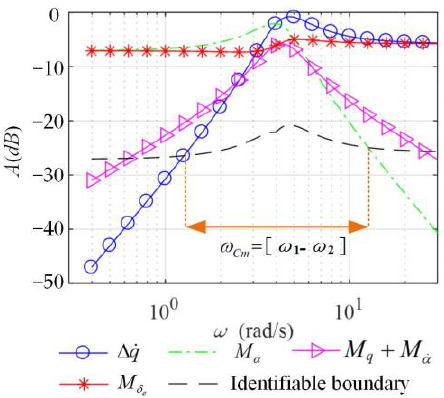
Figure 3. Amplitude–frequency characteristic curve of pitch moment parameters varying with the Figure 3. Amplitude – frequency characteristic curve of pitch moment parameters varying with the excitation signal excitation signal frequency.